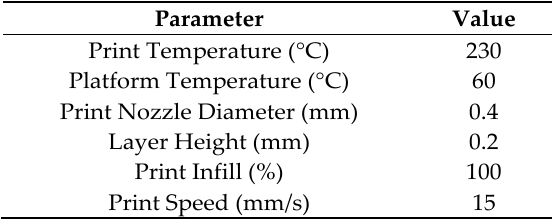
Table 1. FDM parameters used for 3D printing of strain